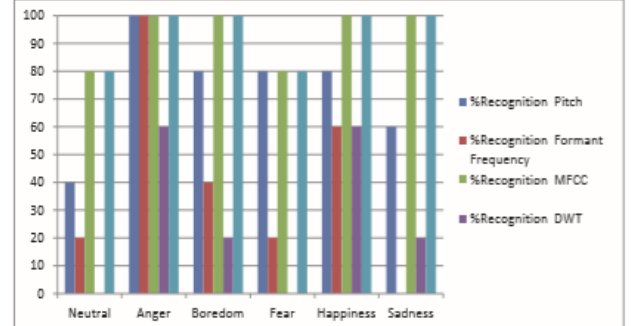
Fig 7. Recognition efficiency using fusion based features